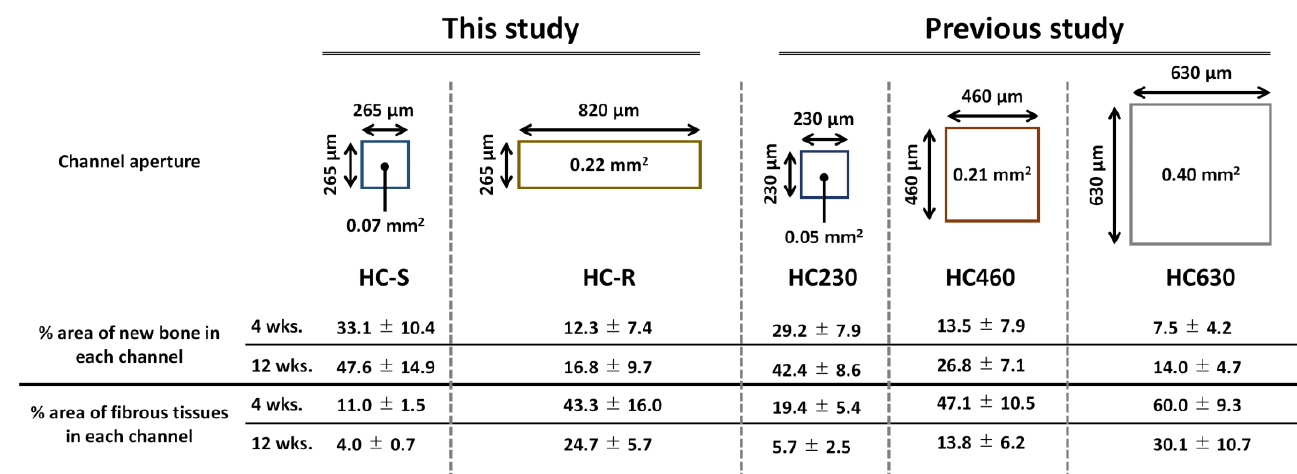
Figure 6. Channel aperture characteristics and the percent areas of new bone and fibrous tissues in each channel of honeycomb scaffolds with square channels (HC-S), with rectangle channels (HC-R), and with square channels of side lengths 230 (HC230), 460 (HC460), and 630 μm ( HC630) [41].